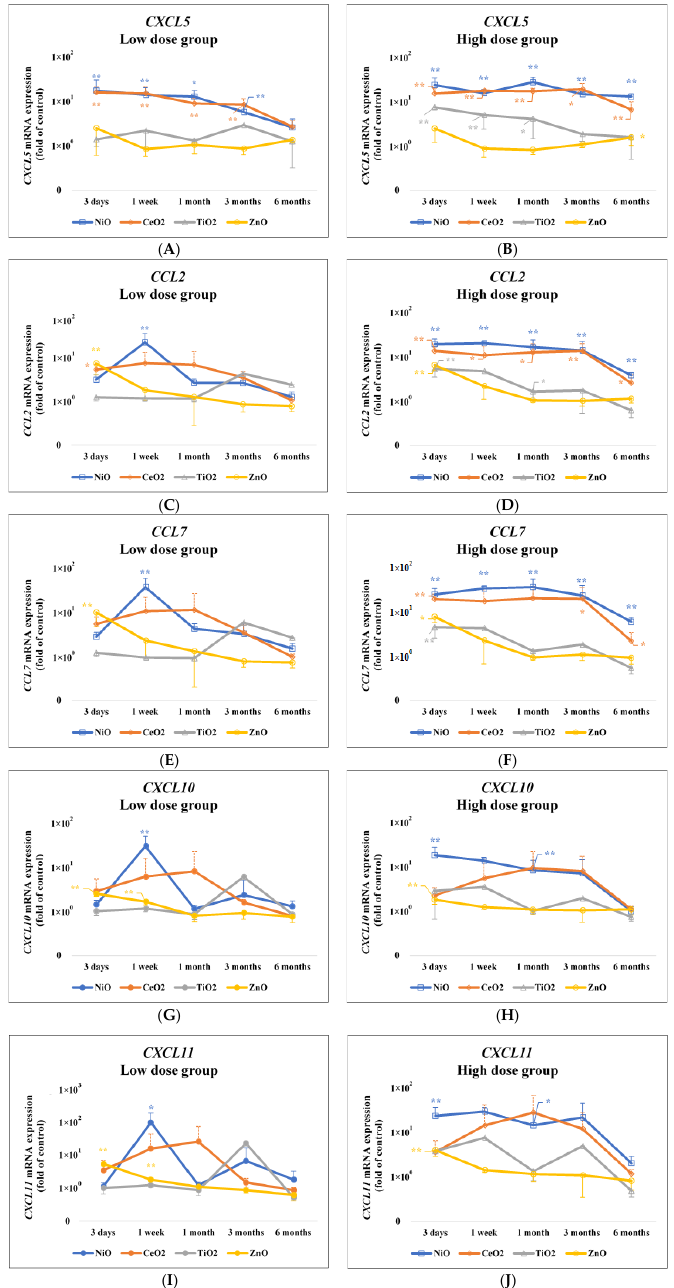
Figure 1. Gene expression of five chemokines in lung exposed to nanomaterials with different pulmonary toxicities. ( A ) CXCL5 mRNA expression (Low dose group); ( B ) CXCL5 mRNA expression (High dose group); ( C ) CCL2 mRNA expression (Low dose group); ( D ) CCL2 mRNA expression (High dose group); ( E ) CCL7 mRNA expression (Low dose group); ( F ) CCL7 mRNA expression (High dose group); ( G ) CXCL10 mRNA expression (Low dose group); ( H ) CXCL10 mRNA expression (High dose group); ( I ) CXCL11 mRNA expression (Low dose group); ( J ) CXCL11 mRNA expression (High dose group). Data, normalized to β -actin endogenous control, are presented as fold change relative to the negative controls (distilled water). Values changes are mean ± standard deviation (SD) ( p < 0.05, n = 5). Increased expression of CXCL5 gene in the NiO and CeO 2 groups was persistently higher, and that in the TiO 2 and ZnO groups transiently higher compared with the negative control groups, respectively. CCL2 and CCL7 also showed a similar tendency to CXCL5 (* p < 0.05, ** p < 0.01). The low dose groups: 0.2 mg; the high dose groups: 1.0 mg. Value of approximate 1 × 10 0 means the negative